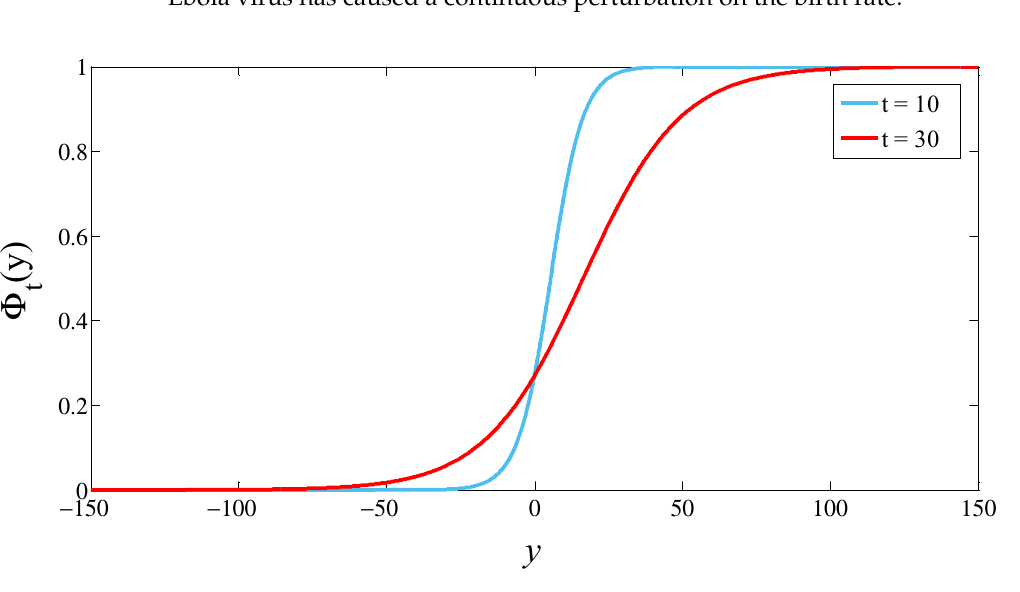
C . Figure 1. Uncertain distribution Φ t